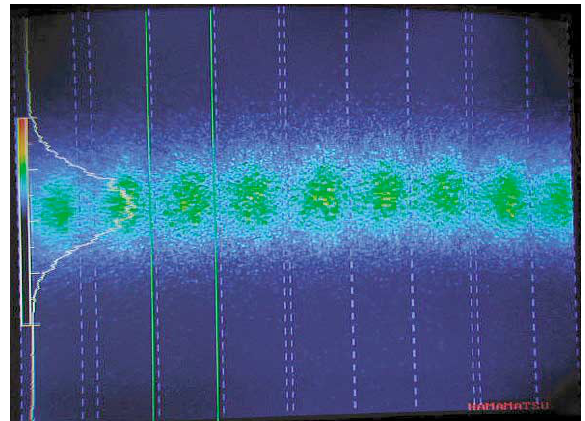
FIG. 24. (Color) A typical image of nine stable trains of bunches of positrons in CESR. The total beam current for this measure- ment was 184 mA.